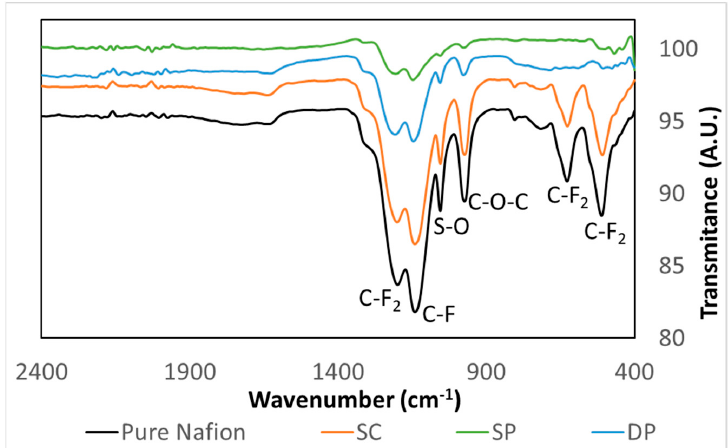
Figure 3. Pure Nafion and photocatalytic membrane FTIR spectra. Membranes 2020 , 10 , x FOR PEER REVIEW